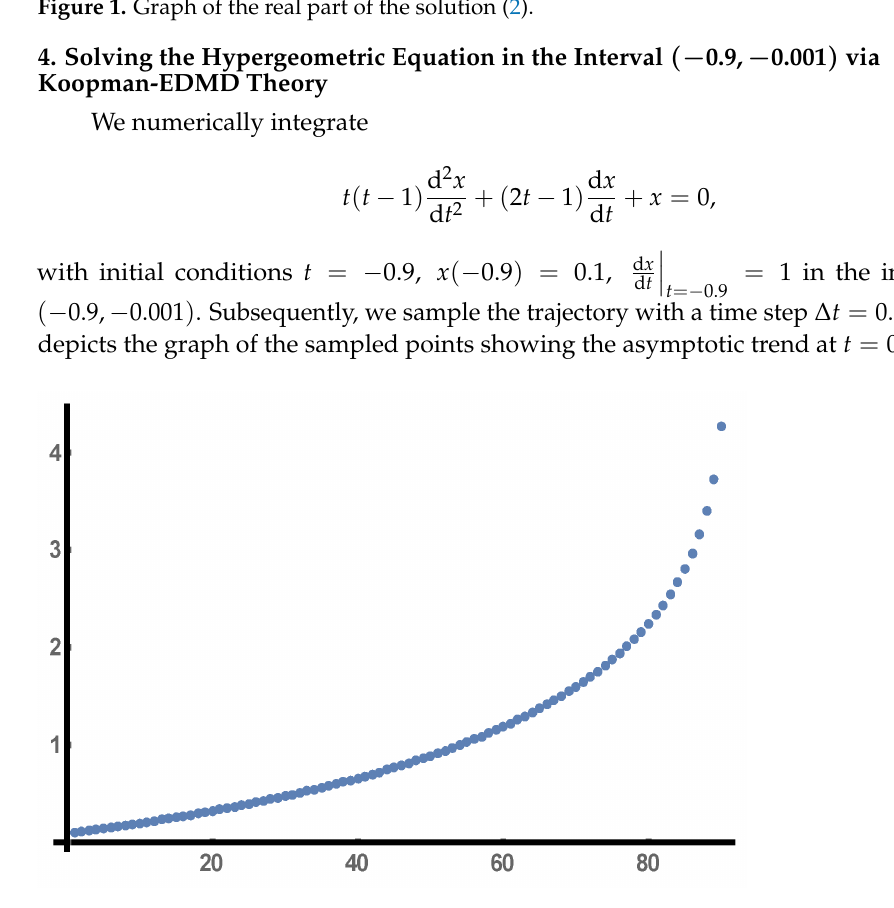
Figure 2. The graph of the sampled points of the hypergeometric Equation